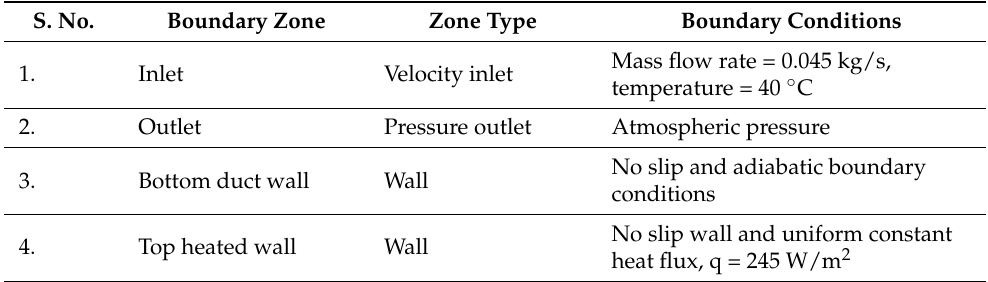
Table 1. Boundary conditions opted for in the present